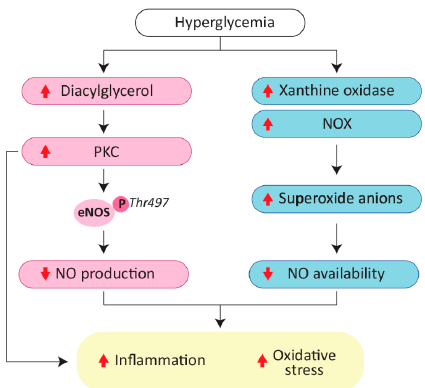
Figure 1. The molecular effects of hyperglycemia, which increases protein kinase C (PKC) activity and therefore enables phosphorylation of endothelial nitric oxide synthase (eNOS) on Thr497, which reduces nitric oxide (NO) production. Moreover, hyperglycemia causes an increase in superoxide anion production, leading to lower NO availability. Inflammation and oxidative stress increase due to NO deficiency. eNOS, endothelial nitric oxide synthase; NO, nitric oxide; NOX, nicotinamide adenine dinucleotide phosphate oxidase; PKC, protein kinase C. The reduction in NO bioavailability has multiple effects. It enhances the action of the nuclear factor kappa-light-chain-enhancer of activated B cells (NF- κ B), which induces the synthesis of pro-inflammatory cytokines, such as interleukin (IL)-1 β , IL-6, and tumor necrosis factor alpha (TNF- α ) [26]. This pro-inflammatory milieu stimulates the endothelial expression of adhesion proteins, leading to the recruitment of immune cells [27,28] with mechanisms that involve either NO or PKC β . Specifically, as suggested by Tabit et al. [23], in patients with T2DM, PKC β activity is linked to the activation of NF- κ B in ECs. Besides the contribution to the worsening of inflammation, pro-inflammatory cytokines lead to the establishment of a pro-coagulant state, as they promote the expression of tissue factor, plasminogen activator inhibitor-1, and von Willebrand factor [26]. Importantly, the effects of NO are not limited to ECs. Since NO mediates the relaxation of VSMCs [29], in the case of T2DM, the misbalance in NO and vasoconstrictors, such as endothelin, contributes to the impairment of vascular tone and blood flow [15]. Alterations in blood flow cause endoplasmic reticulum stress and downregulation of endothelial cadherin, which lead to apoptosis [16,30]. In this context, CECs may play a relevant role as circulating cells that repair the sites of endothelial injury. However, in patients with T2DM, the amount and functionality of CECs are reduced, which contributes to evident alterations in the reparation process [16]. NO deficiency is not the only mechanism by which hyperglycemia exerts pathological complications on vessels. Excess glucose is responsible for irreversible glycation of protein, thus producing advanced glycation end products (AGEs), which have a pathological effect not only on ECs due to oxidative stress and protein dysfunction but also on other endothelial components [31]. In particular, AGEs cause vascular